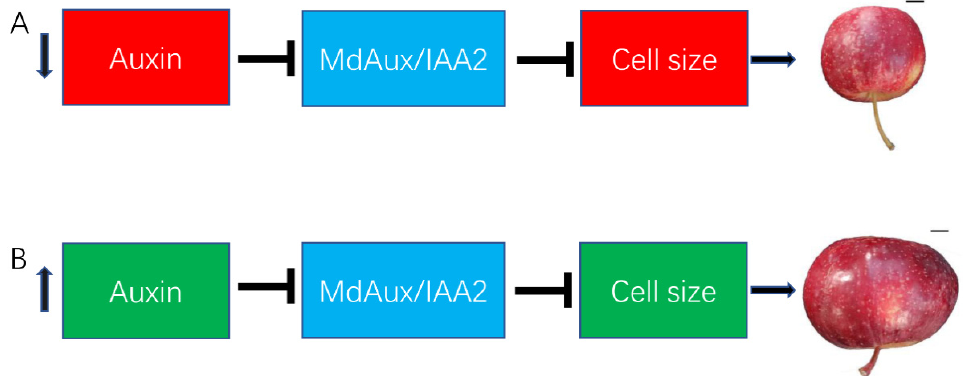
Figure 6. A working model of MdAux/IAA2 for regulating apple fruit size. A model role of MdAux/IAA2 in auxin-mediated differences in fruit size between LF and GLF. MdAux/IAA2 nega- tively regulates apple fruit and cell size; thus, in the absence of auxin, MdAux/IAA2 is enhanced, and the LF apple has a small cell size and fruit size. Bar, 10 mm ( A ). When the auxin content is high, MdAux/IAA2 may be degraded by TIR1/AFB (a component of E3 ubiquitin ligase), and the negative regulation of MdAux/IAA2 in apple cell size was eliminated, resulting in the larger fruit size of GLF. Bar, 10 mm ( B ).